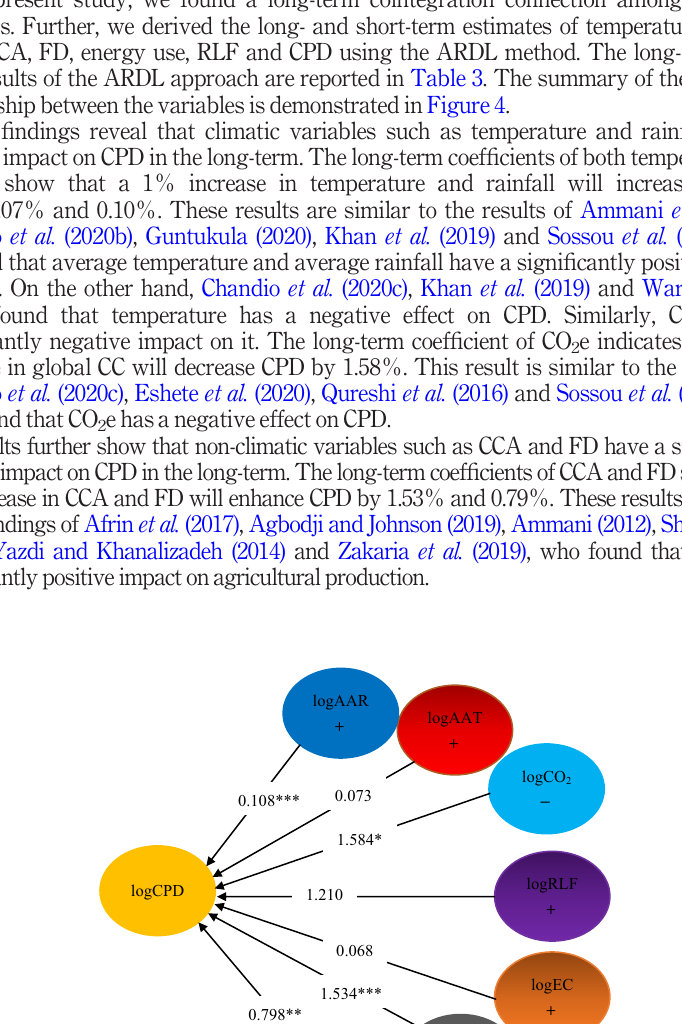
Note: ***, ** and * show the significance at 1%, 5%, and 10% level, respectively. + sign indicates positive association and − sign indicates negative association among